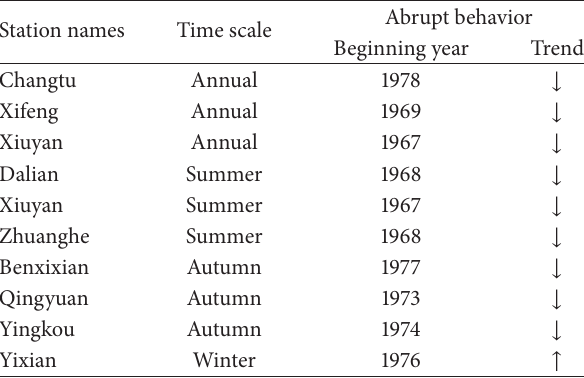
Table 2: Analysis for significant trends using sequential Mann- Kendall rank statistic